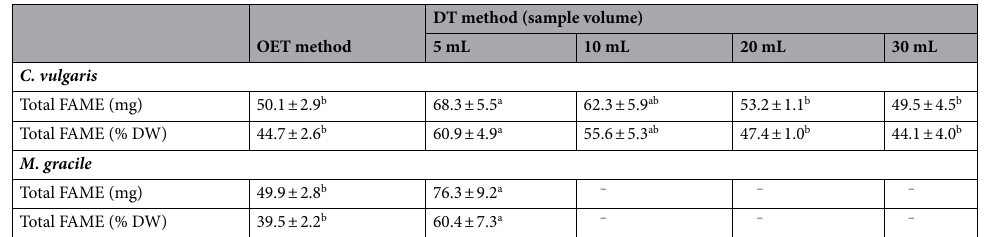
Table 2. Total FAME obtained from C. vulgaris and M. gracile using oil-extraction transesterification (OET) and direct transesterification (DT) methods from 0.3 L culture. For DT method, fresh cells were harvested from 5, 10, 20, and 30 mL of stationary phase microalgal cultures. The values are in mean ± SD (n = 3). Different letters in the same row indicate values are significantly different according to one-way ANOVA at p <